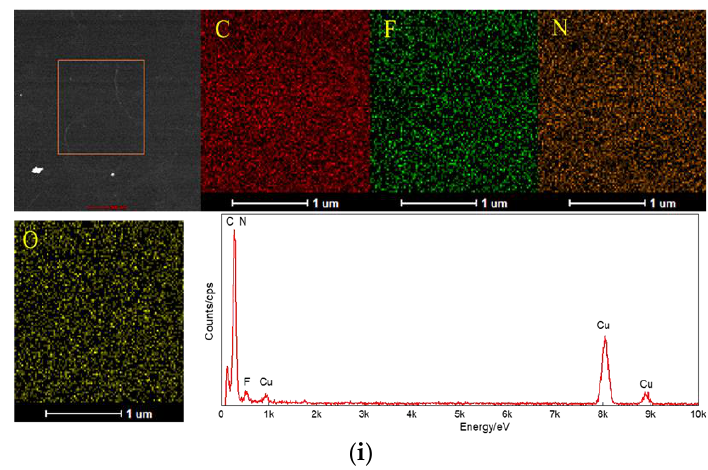
Figure 4. Morphology of FNG film under micron-scale ( a ), under submicron-scale ( b ), nano-scale ( c ), and reduced FFT ( d ). The nanostructure ( e ) and FFT ( f ) of zone A, and the amorphous structure ( g ) and FFT ( h ) of zone B were analyzed. Element distribution of FNG film was detected ( i ).